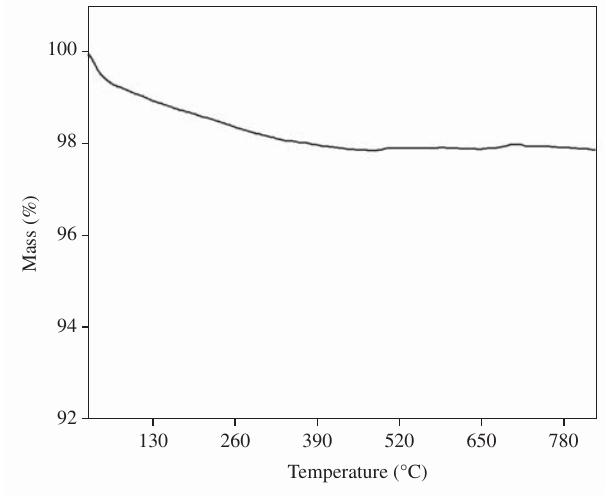
Figure 1. Thermogravimetric plot of the spinel polymeric precursor. Figure 2. X-ray diffraction patterns of the polymeric precursor and powders calcined at 500 °C, 700 °C, and 900 °C for 4 hours.